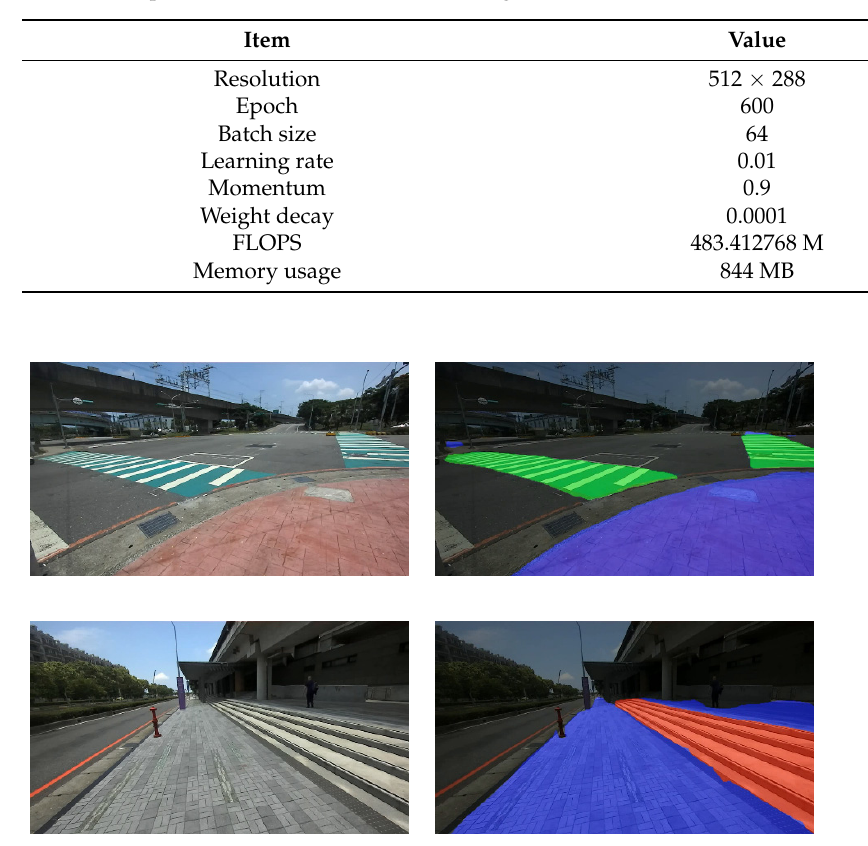
Table 2. The parameters used in network training.